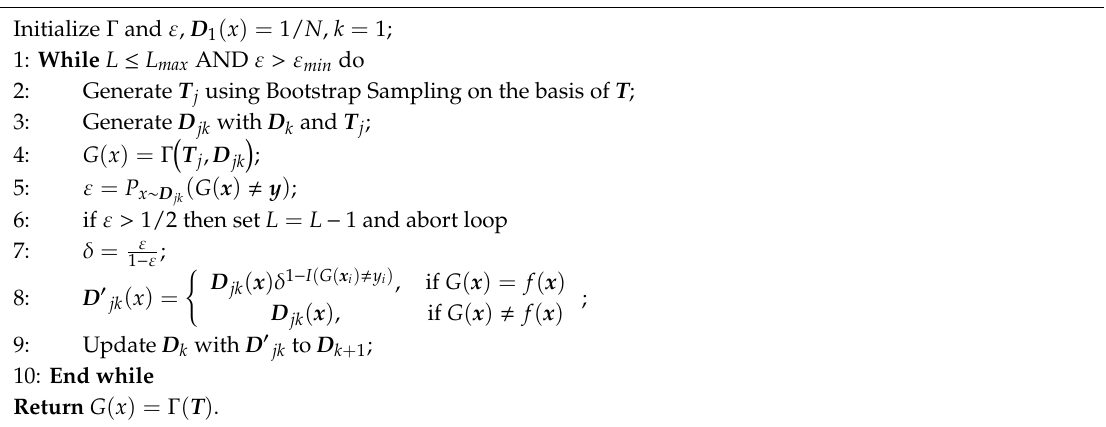
Algorithm 3: The pseudo code of AdaBoost-Bootstrap-SCN